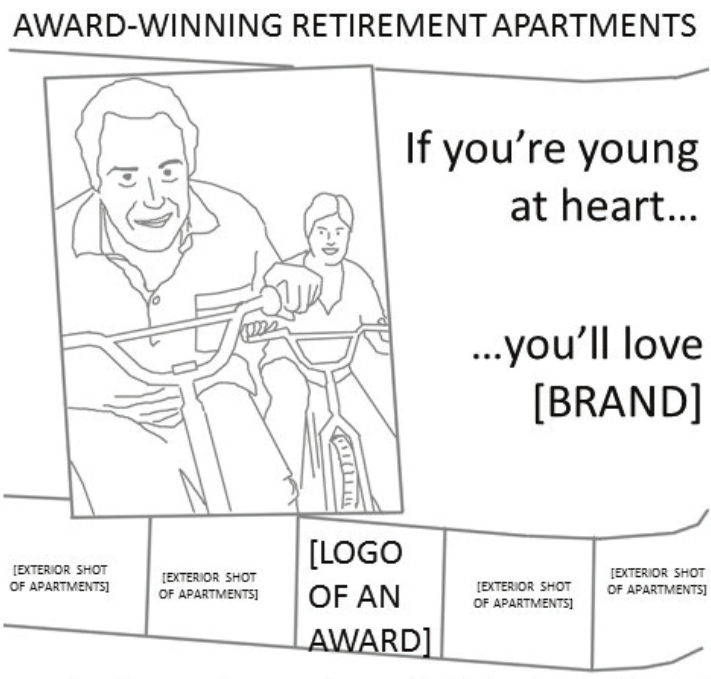
Figure 2. Example